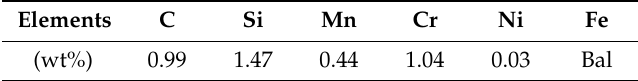
Table 1. Chemical composition of the experimental steel (wt%). Elements